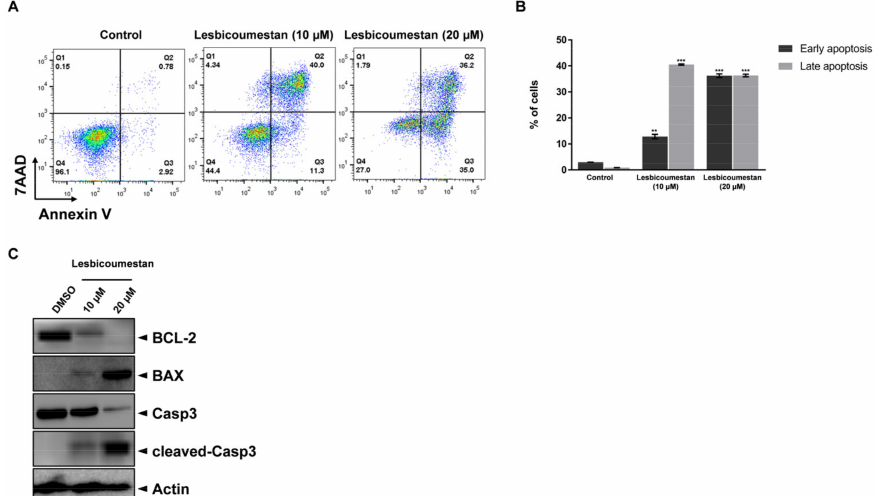
Figure 2. Lesbicoumestan-induced apoptosis. ( A ) Jurkat cells were either treated with lesbicoumestan or untreated for 48 h. Flow cytometry was subsequently employed to evaluate apoptosis. ( B ) Quan- tification results of early and late apoptotic cells ( n = 3, ** p ≤ 0.01, *** p ≤ 0.001 vs. control group). ( C ) Whole-cell lysates from lesbicoumestan-treated cells were immunoblotted with antibodies specific for BCL-2, BAX, caspase-3 (Casp3), and cleaved caspase-3